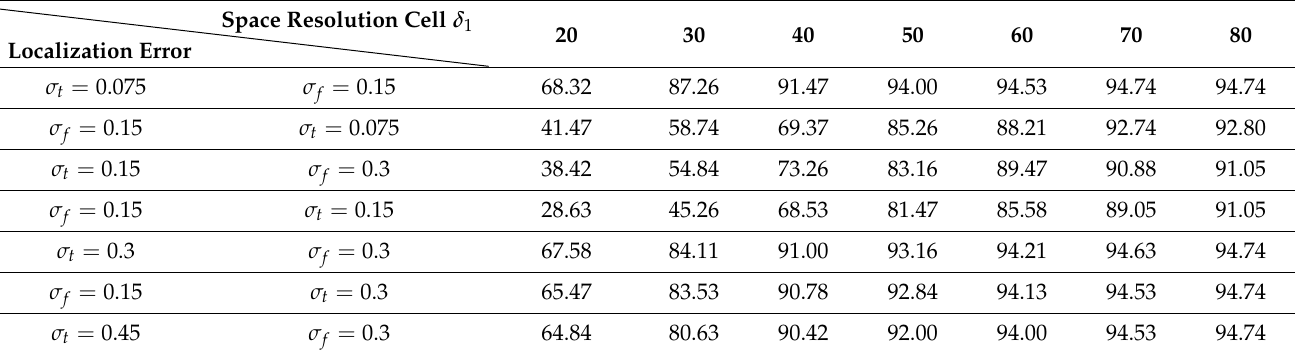
Table 5. The pass ratio of the same source testing under different radar resolution and different localization error (unit of pass ratio: %).